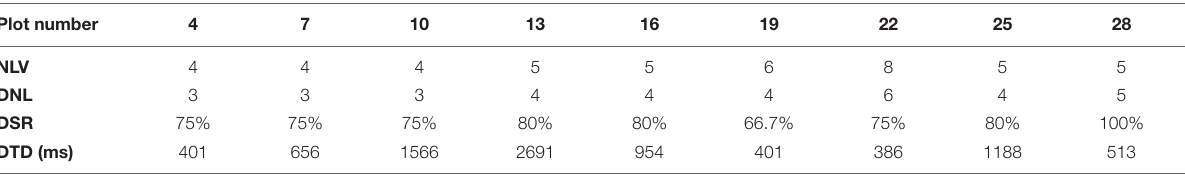
FIGURE 11 | Locations of all manually measured plant height samples. TABLE 2 | Landmark detection results for Parcel-1.